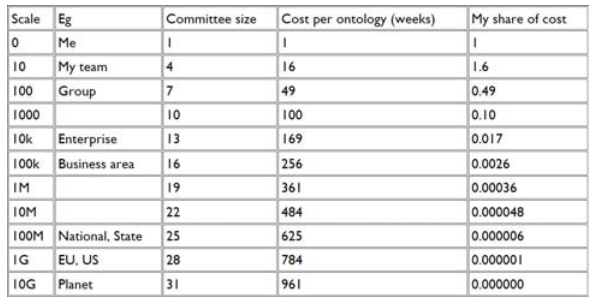
Figure 39: Berners-Lee (2005) Total cost of ontologies. This table assumes ontologies are evenly spread across orders of magnitude, committee size is reasonably represented by log(community), time is community**2, and costs are shared evenly over the community. The scale column represents the community size from which the committee size and costs are calculated. The general conclusion is that the cost of large efforts is huge, but it is borne by and benefits an even larger group and so the cost per individual is very, very small